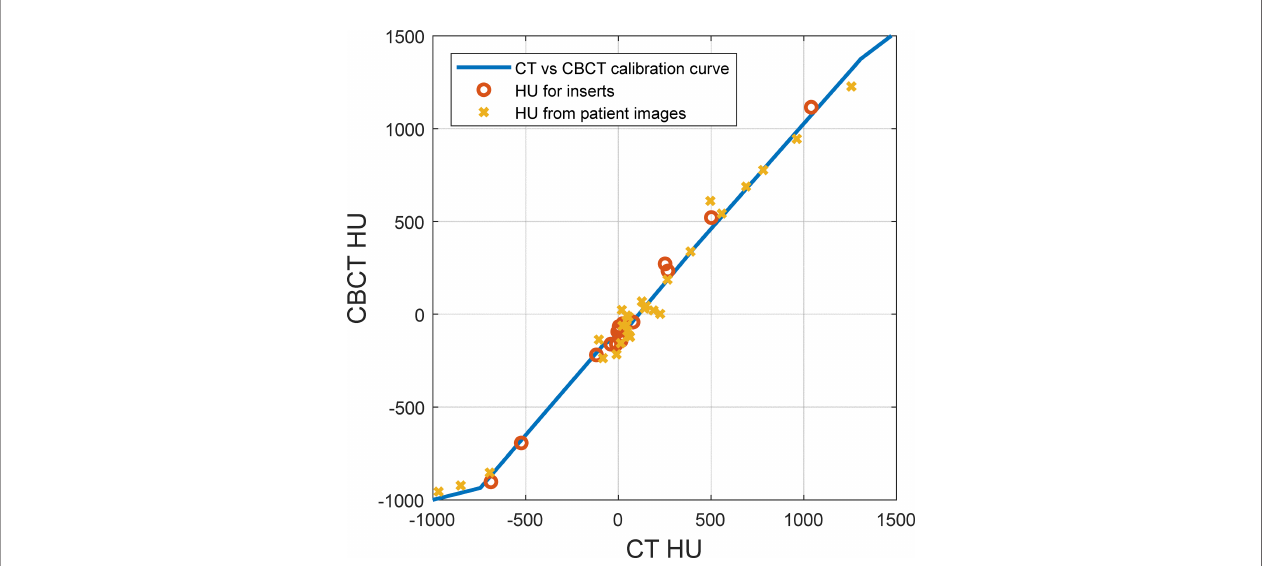
FIGURE 4 | Houns fi eld unit (HU) comparison between CT and cone-beam CT (CBCT) for the same materials. The solid line represents the HU-D calibration curve, the circles represent inserts on the CT density phantom with known densities, and the crosses represent volumes of interest with nearly homogenous density on patient images.